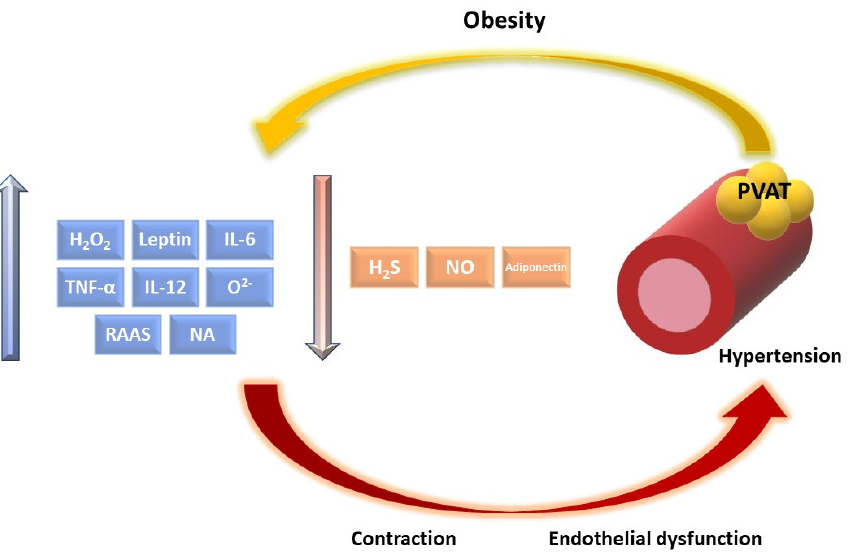
Figure 2. The influence of obesity on PVAT-derived factors’ synthesis resulting in vascular dysfunction. (PVAT: perivascu- lar adipose tissue, RAAS: renin–angiotensin–aldosterone system, NO: nitric oxide, H 2 S: hydrogen sulfide, H 2 O 2 : hydrogen peroxide, TNF– α : tumor necrosis factor α , and NA: